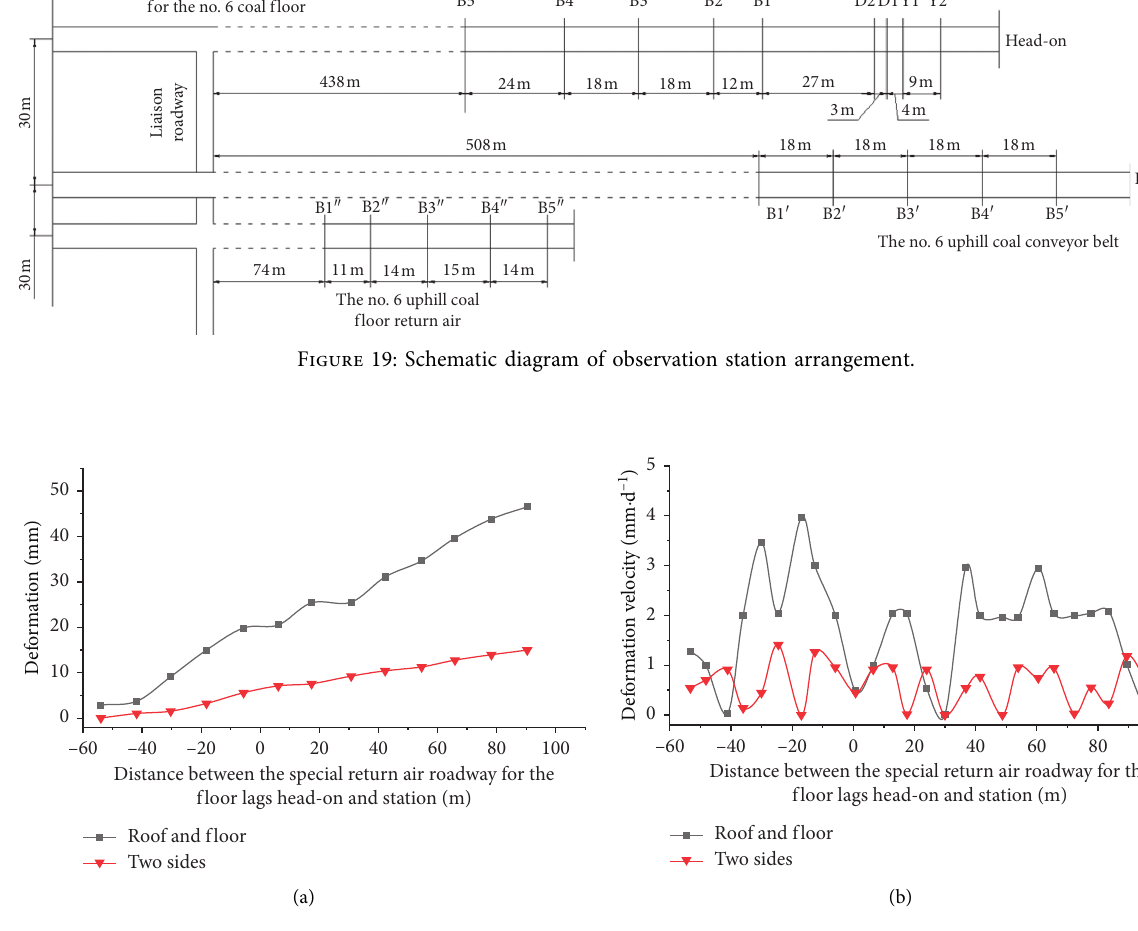
Figure 20: Deformation and deformation velocity of the floor return air uphill under the influence of special air-return roadway blast excavating: (a) deformation and (b) deformation